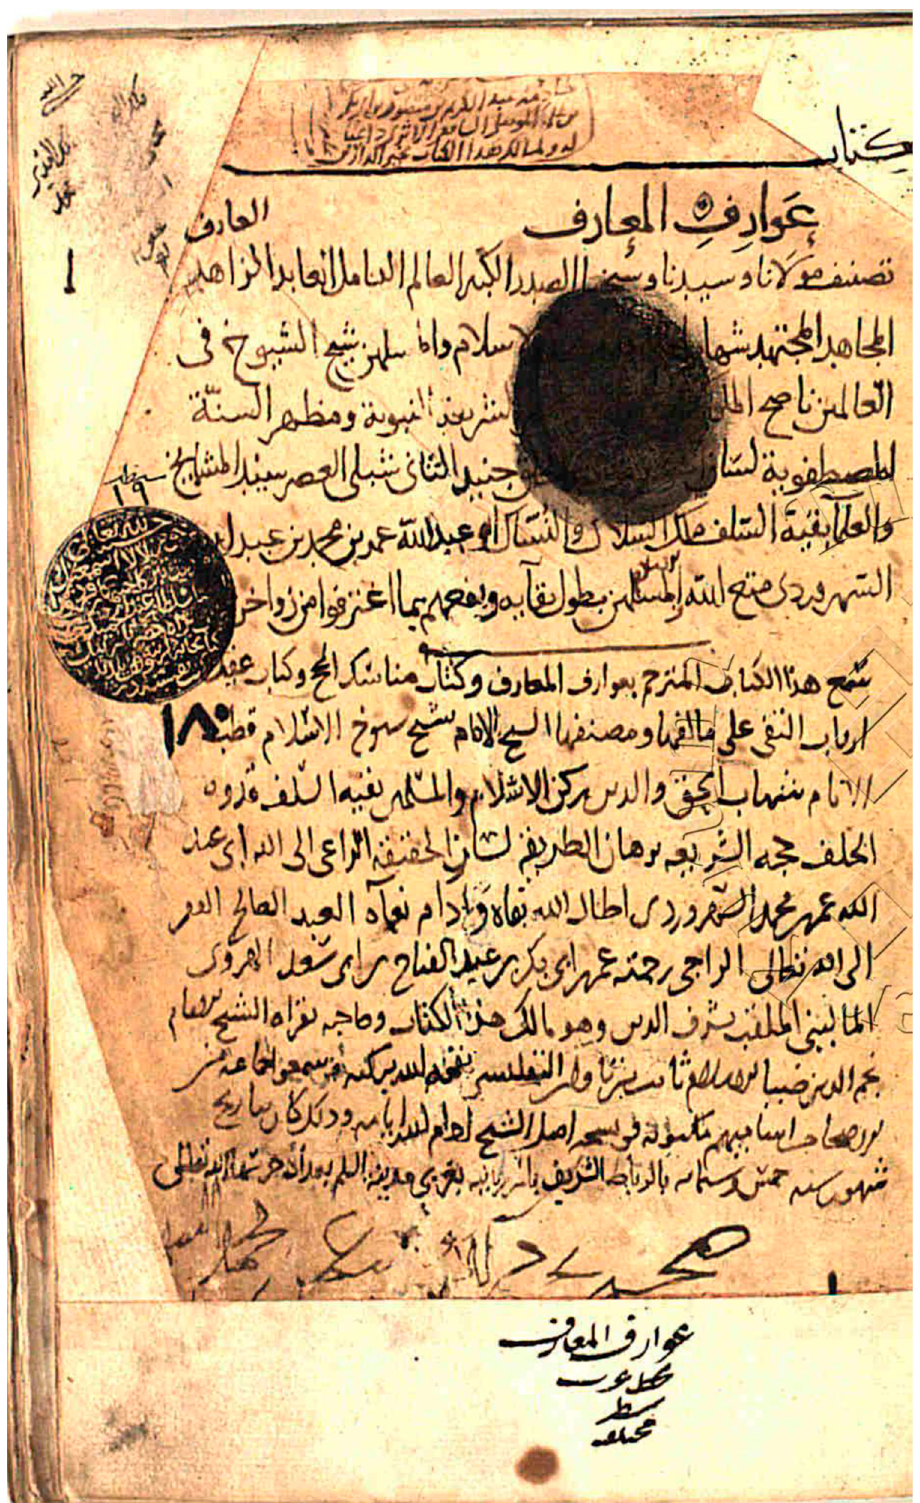
Figure A3. MS Lala Ismail 180, f.1a (audition record with the autograph of al-Suhraward ī on the bottom margin).